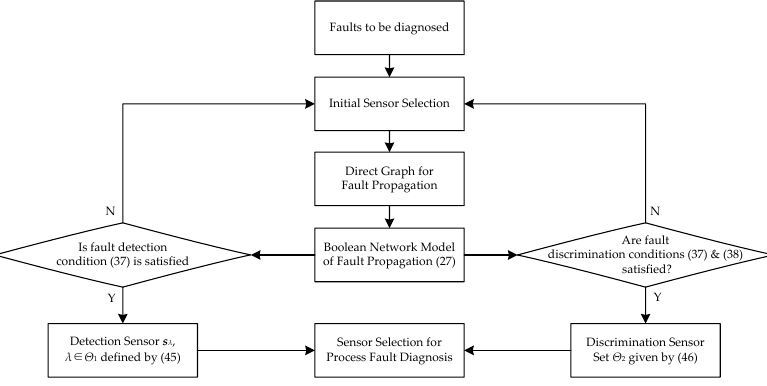
Figure 1. Implementation steps of the Boolean network (BN)-based sensor selection